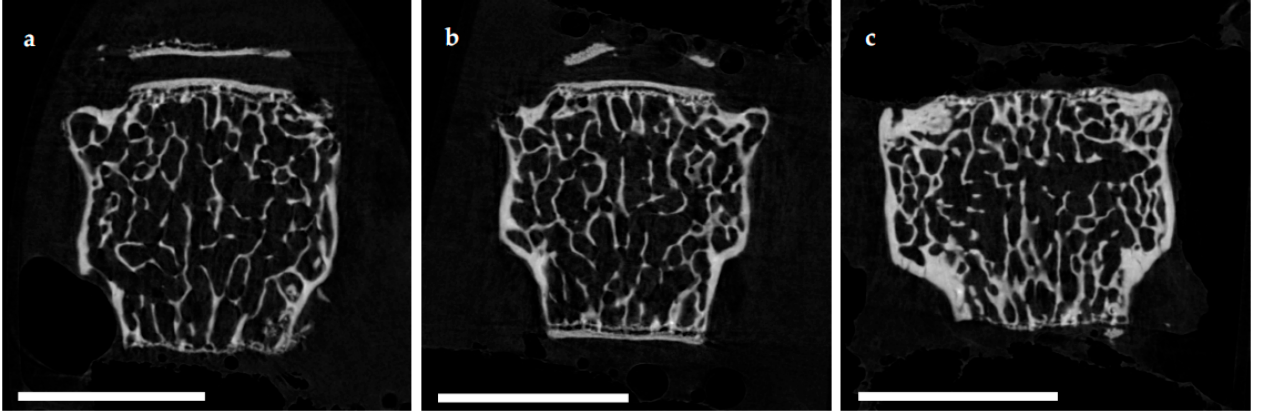
Figure 6. Two-dimensional images from µ CT scans of vertebral bodies L1 (scale bar 2 mm). Mice were immunized with ( a ) testicular homogenate in adjuvant (EAO), ( b ) adjuvant alone or ( c ) remained untreated.